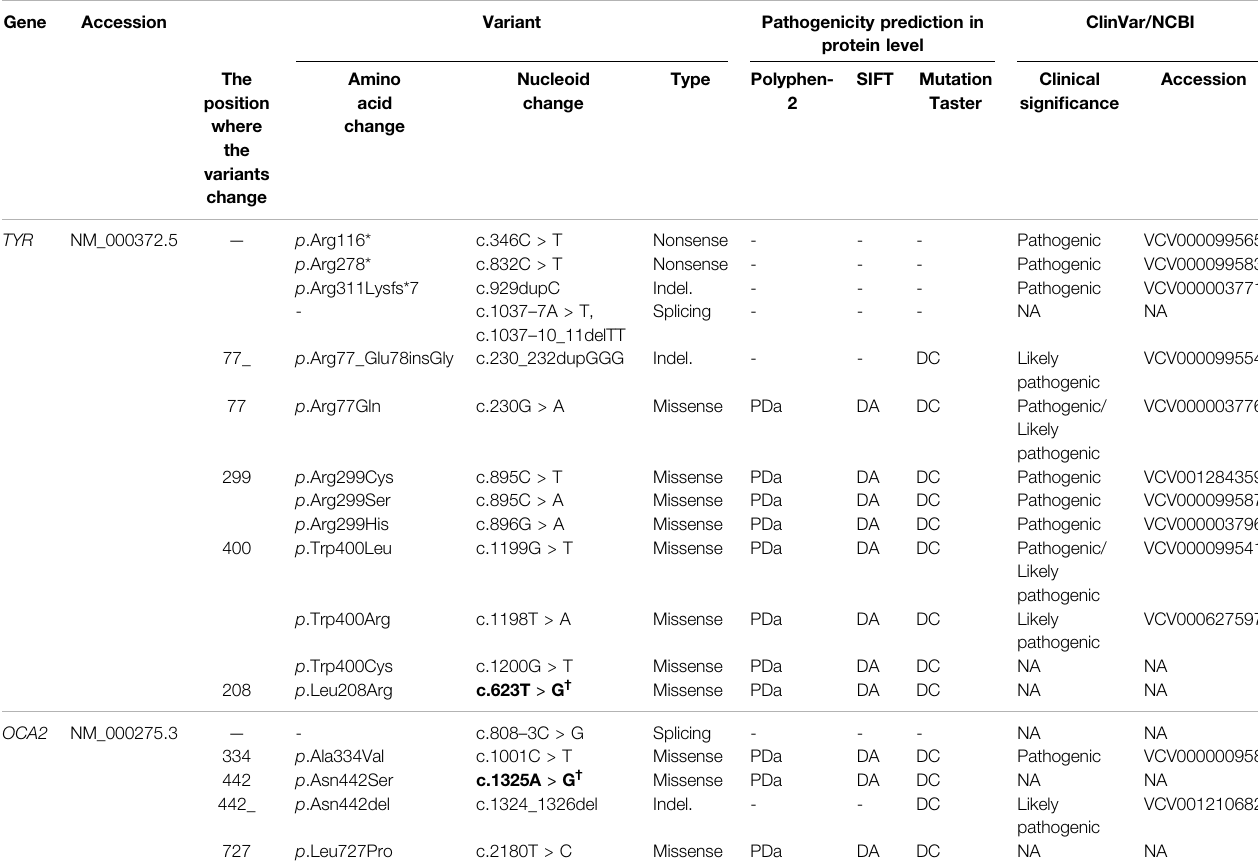
† indicatesanovelvariantinboldandanovelpatientismarkedwitha#sign.NAindicatestheitemswithoutdataavailable.Variantsmarkedwithahyphenarenotnecessarytobepredicted orimpropertobepredictedtheirpathogenicityinproteinlevel via SIFT,Polyphen-2;PROVEANandMutationTaster.nonsensevariants,frameshiftIndel,andsplicingvariantsmaychange moreresiduesandproteinlengthsothatthepositionwheretheychangecannotbepredictedandisindicatedbytheslashintheabovementionedtable.In-frameIndelmayleadtodeletion or insertion of amino acids and change protein length and so the position where they change is indicated by the number followed underline. Grayish lattices are the variants that have information in ClinVar and change at the same residues as where the variants identi fi ed in this study change. InDel, insertion or deletion; NA, not available; probably damaging, PDa; Da, damaging; deleterious, De; disease-causing,